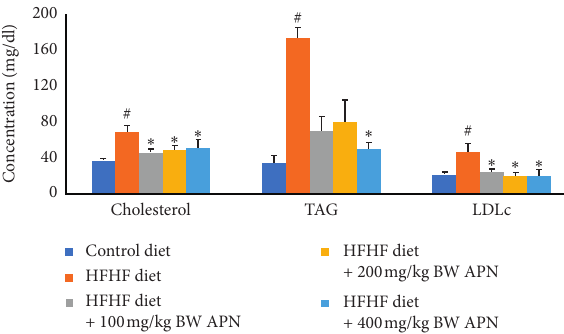
Figure 1: Effect of APN on cholesterol, triacylglycerol, and low-density lipoprotein cholesterol of rats fed an HFHF diet. Values are represented as mean ± SEM of at least five biological replicates. Bars with # are significantly ( P < 0 . 05) different from control while bars with ∗ are significantly different ( P < 0 . 05) from HFHF-fed group.